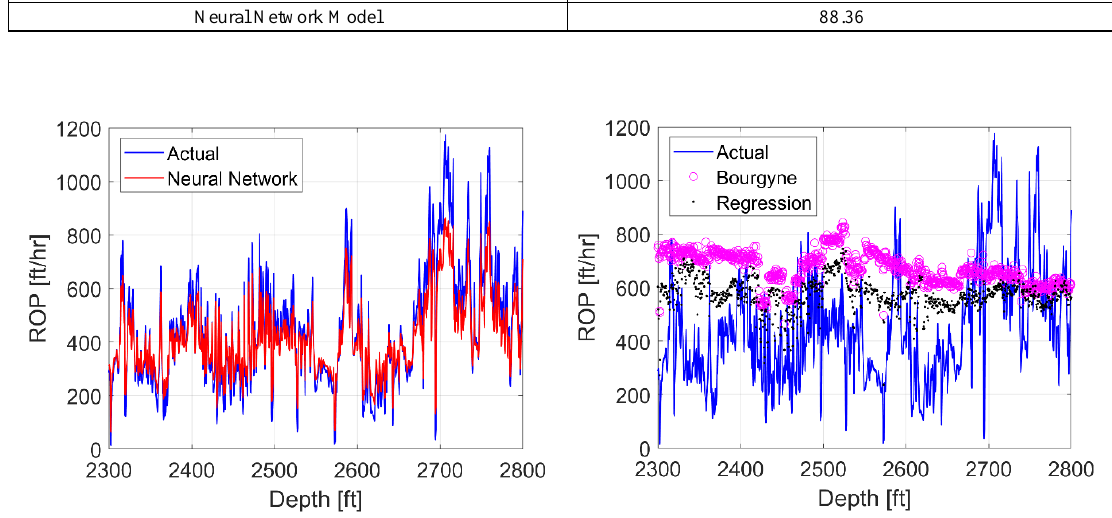
Figure 8. ROP prediction by neural network, Bourgyne and Young model and multivariate